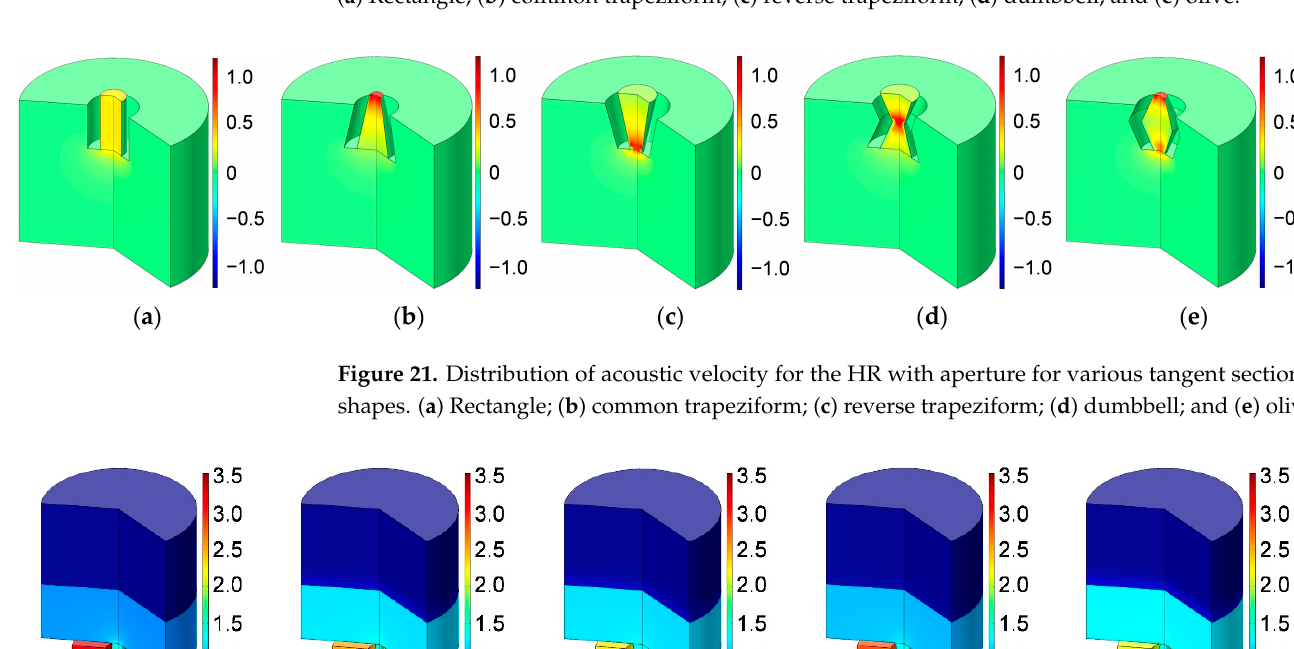
Figure 20. Distribution of temperature for the HR with aperture for various tangent sectional shapes.